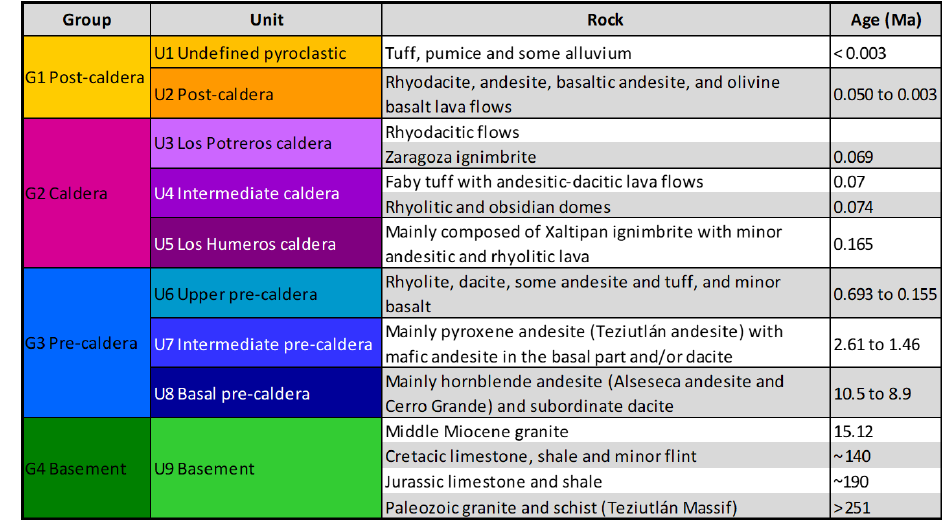
Figure 3. Description of the geological formations modelled in Los Humeros at regional scale gathered into four groups and nine units.